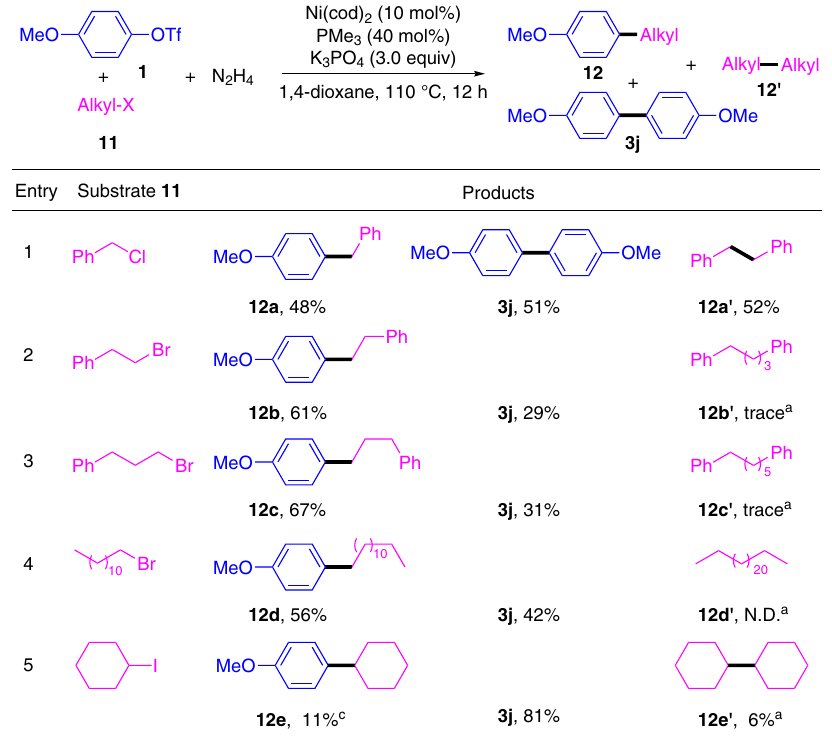
Fig. 7 Cross-coupling between aryl tri fl ates 1 and alkyl halides 11 . Reaction conditions: 1 (0.1 mmol), 11 (0.3 mmol), N 2 H 4 (0.2 mmol), Ni(cod) 2 (10 mol%), PMe 3 (40 mol%), K 3 PO 4 (0.6 mmol), 1,4-dioxane (1.0 mL), 110 °C, 12 h under N 2 . Reported yields are the isolated ones. a The yield was determined by